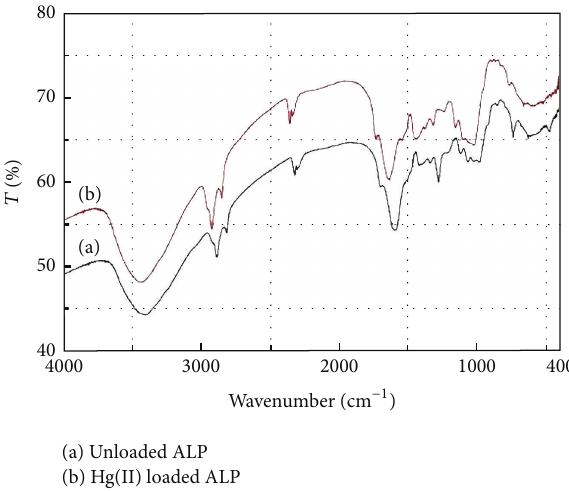
Figure 1: FTIR spectra’s of (a) unloaded ALP and (b) Hg(II) loaded